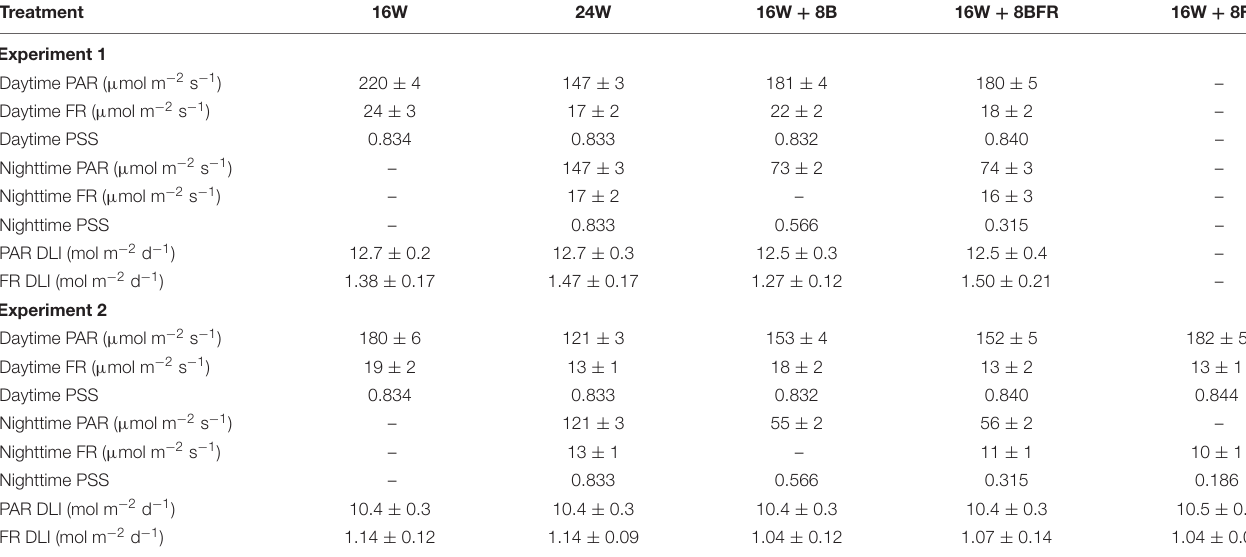
TABLE 1 | Supplemental light intensities provided by Sollum SF04 fixtures of lighting treatments in experiments one and two where the daytime is defined as 6:00-22:00 and nighttime is 22:00-6:00.